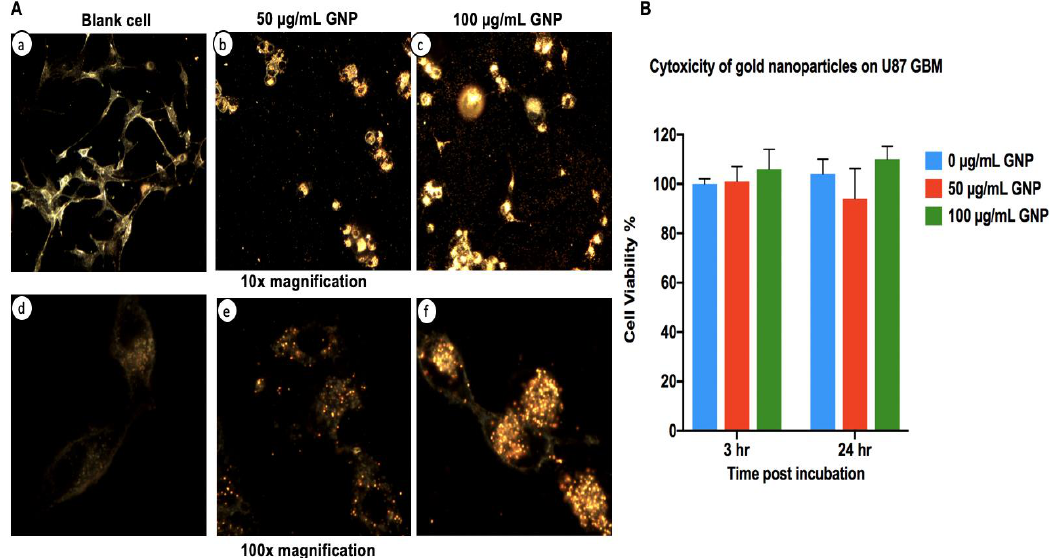
Figure 2. Gold nanoparticle association and cytotoxicity with U87 GBM cells. Figure 2 A shows images from dark field microscopy under 10× magnification (panels a – c ); a large number of gold nanoparticles were observed in association with the cells at the 100 μg/mL exposure level. Substantial amounts were also seen in 50 μg/mL samples. Under 100× magnification (panels d – f ), increased GNP association with cells is observed with increasing concentrations of GNPs. Figure 2 B shows an MTS viability assay of U87 GBM cells pretreated with increasing concentrations of GNPs at 3 and 24 h, respectively. No significant difference (as tested by ANOVA, see Methods) was observed between the three groups. Error bars represent the standard deviation of mean for three independent repeats ( n = 3).